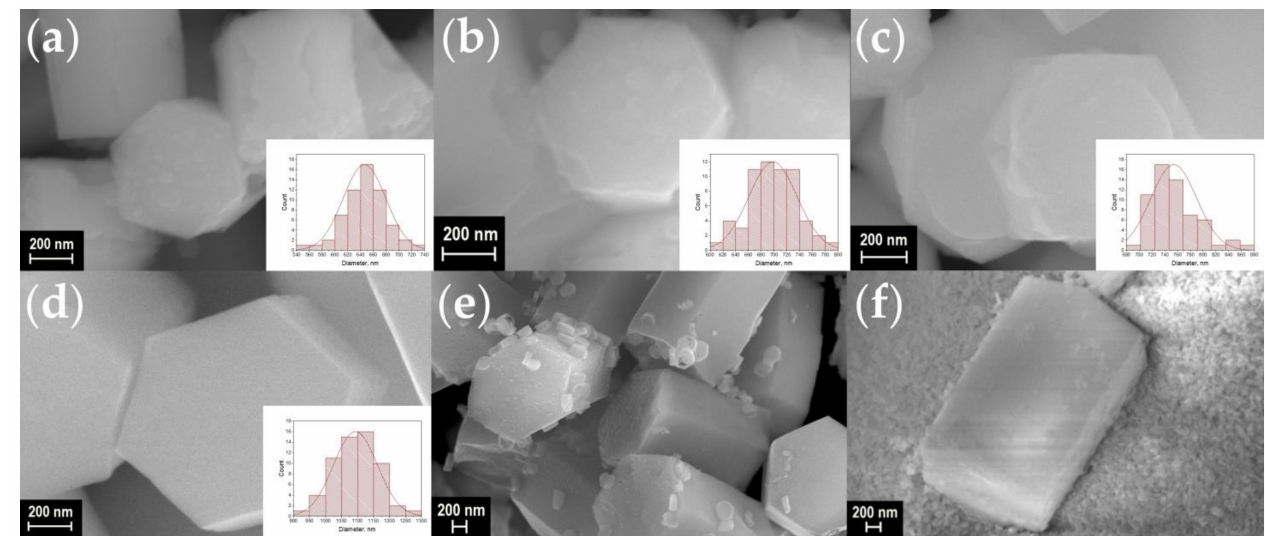
Figure 4. SEM images of the samples NaY 0.98 − x Sm 0.02 La x F 4 ( a – f ): x = 2, 5, 10, 20, 40, and 60 at.% La. Particle size distribution of the samples is shown in the insets. The average diameter of particles is equal to about 646 ± 33, 698 ± 38, 754 ± 36, 1094 ± 69, 1517 ± 64 (254 ± 16 for small particles) and 1916 ± 132 (102 ± 9 for small particles) nm for the La 3+ concentration of 2, 5, 10, 20, 40, and 60 at.%, respectively.